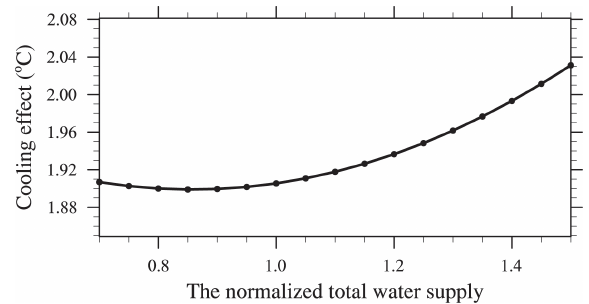
Figure 13. Sensitivity analysis based on the normalized total water supply and the cooling